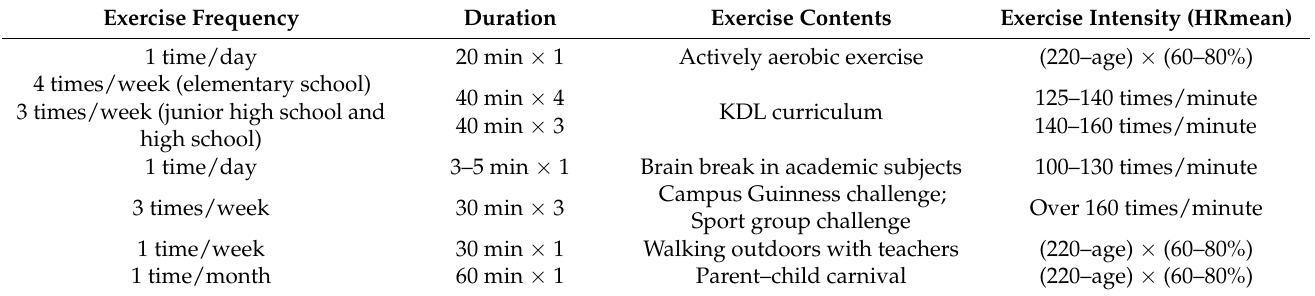
Table 4. The specific requirements of the KDL-ASP